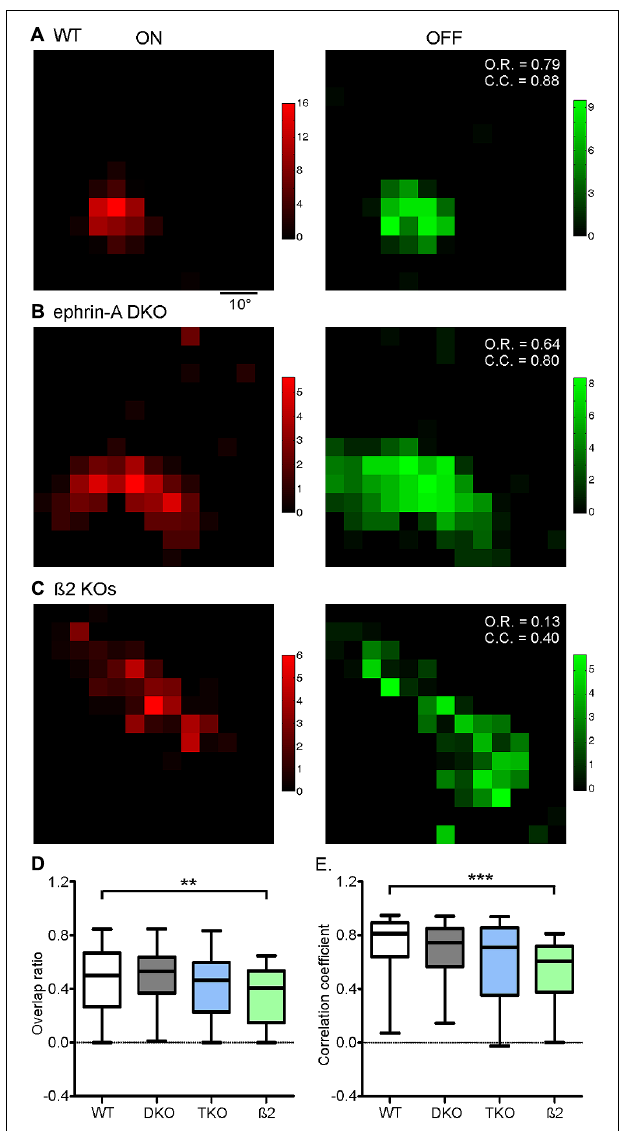
FIGURE 3 | On–Off overlap is disrupted in nAChR- β 2 KOs, but not in ephrin-A KOs. (A) On (red) and Off (green) responses of aWT SC neuron, showing substantial On–Off overlap. Color scales represent evoked responses in spikes/s during the 500 ms duration of stimulus presentation. The calculated values of overlap ratio (O.R.) and correlation coefficient (C.C.) are listed at the upper right corner of the “Off” plot. (B) On and Off responses of an example neuron in ephrin-A DKO mice. (C) Responses of an example neuron in nAChR- β 2 subunit knockout. (D) Comparison of On–Off overlap ratio between genotypes, with only β 2 KOs showing a significant disruption comparing to theWT. (E) Comparison of On–Off correlation coefficient between genotypes. Panel D and E are box plots with ends of each plot representing 5th and 95th percentiles. ** p < 0.01 and *** p <